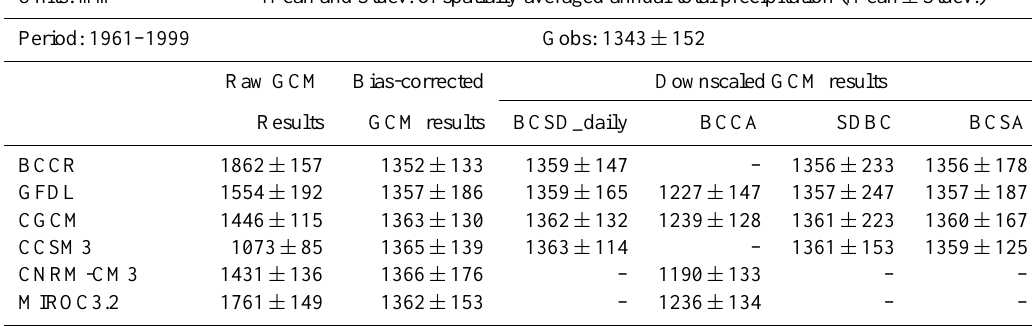
Table 2. The mean and standard deviation (Stdev.) of spatially averaged annual total precipitation over the state of Florida for the raw GCM outputs, bias-corrected GCM results (at GCM scale), and downscaled results using 4 different statistical downscaling methods. Units: